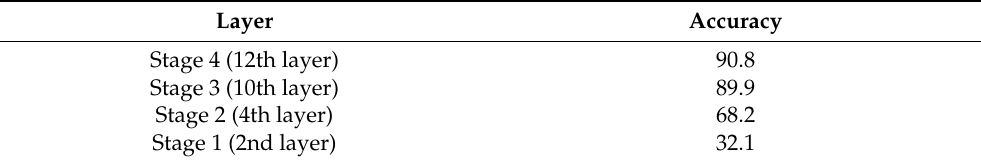
Table 2. Accuracy of different layers.